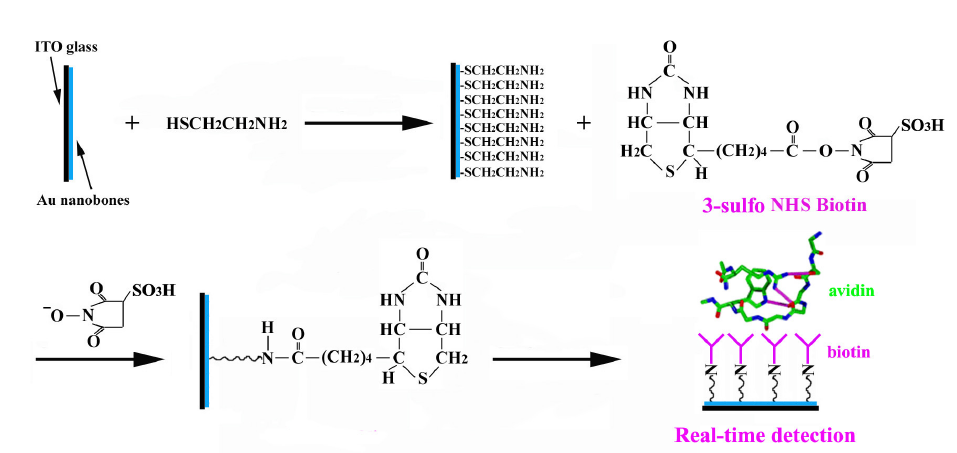
Figure 6. Schematic illustration of the real-time determination of